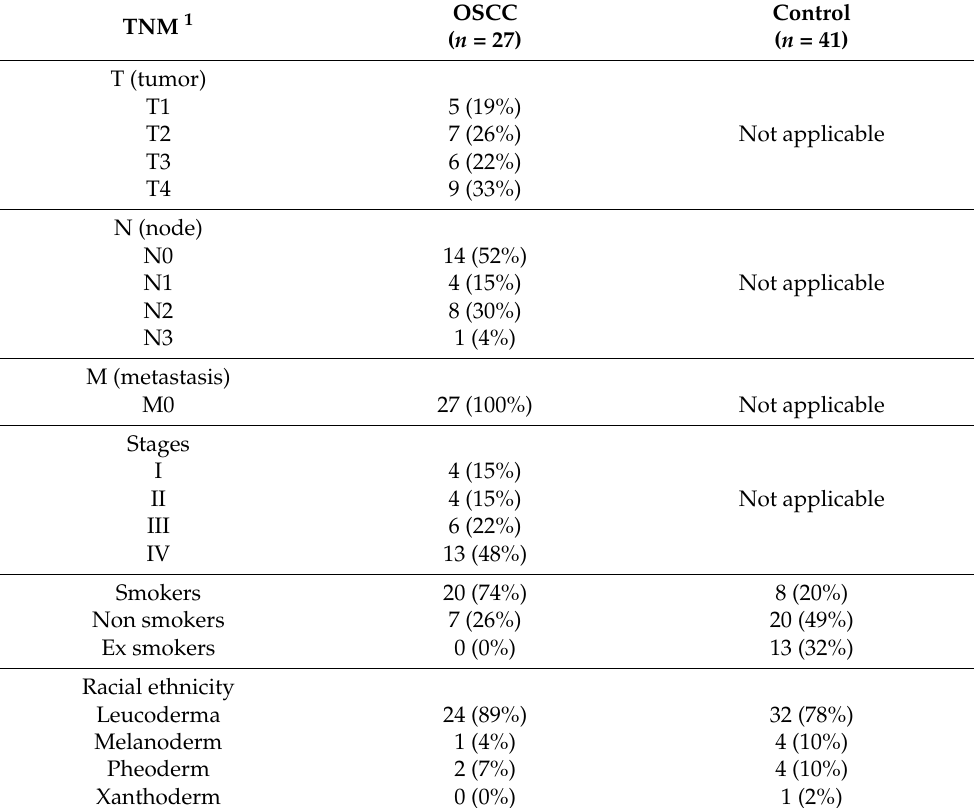
Table 2. Cancer staging system, smoking habits, and racial ethnicity of